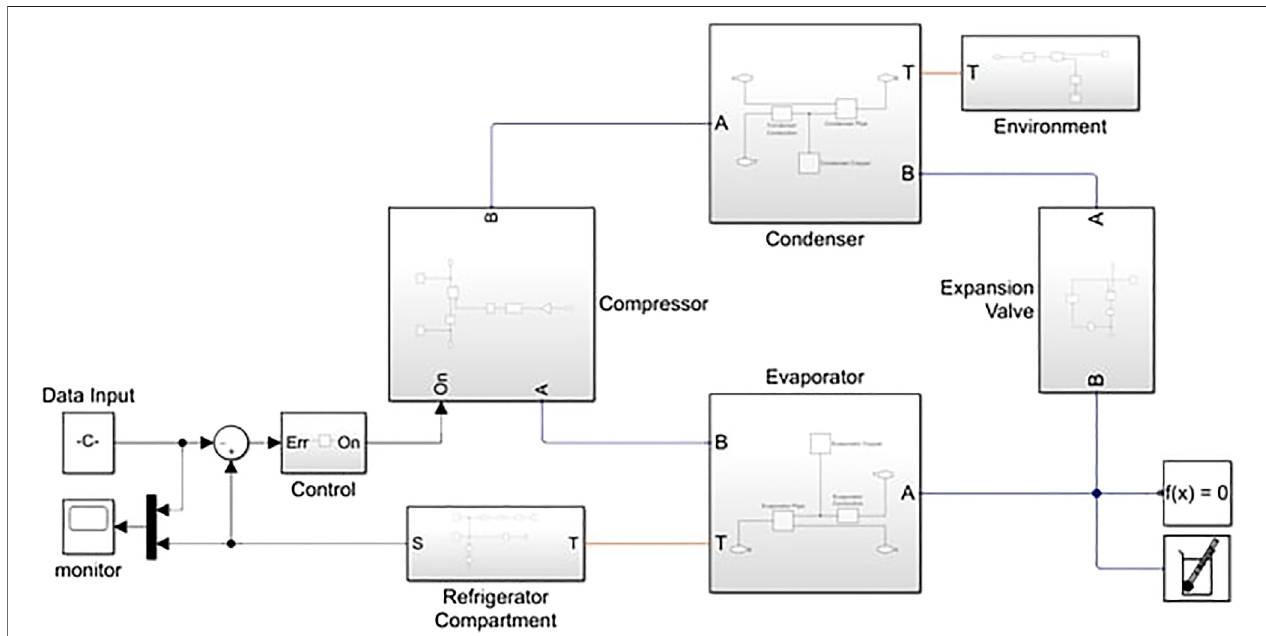
FIGURE 4 | Refrigerator model in MATLAB